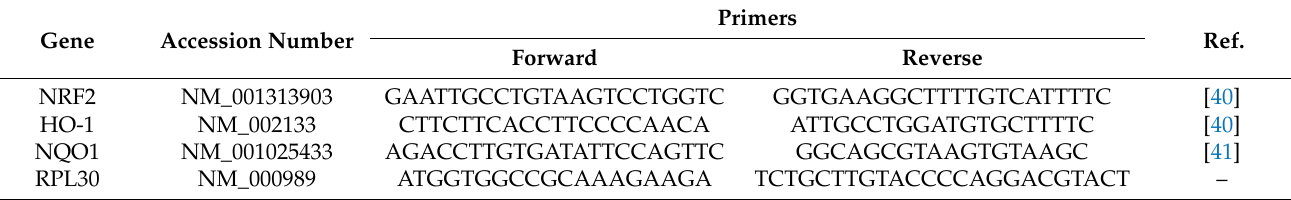
Table 1. Primers sequences used in the analysis of gene